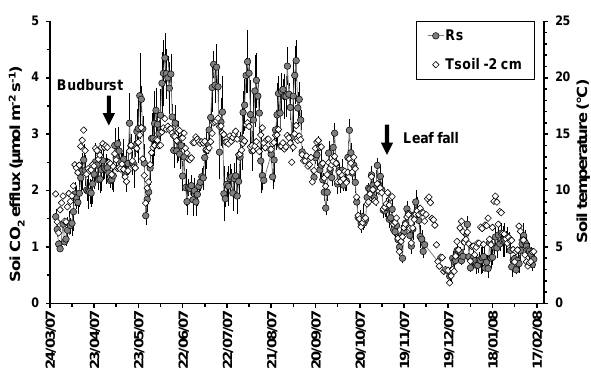
Fig. 1. Mean daily CO 2 efflux from soil respiration ( R s ) measured from surface collars and soil temperature ( T soil ) at 2cm depth at the Straits Enclosure, Alice Holt forest from 24 March 2007 to 17 February 2008. Bars indicate ± s.d. ( n = 12 until 18 September and thereafter n = 4), and arrows indicate the approximate onset of budburst (1 May) and leaf fall (1 November) of the oak canopy. Gaps were due to system power